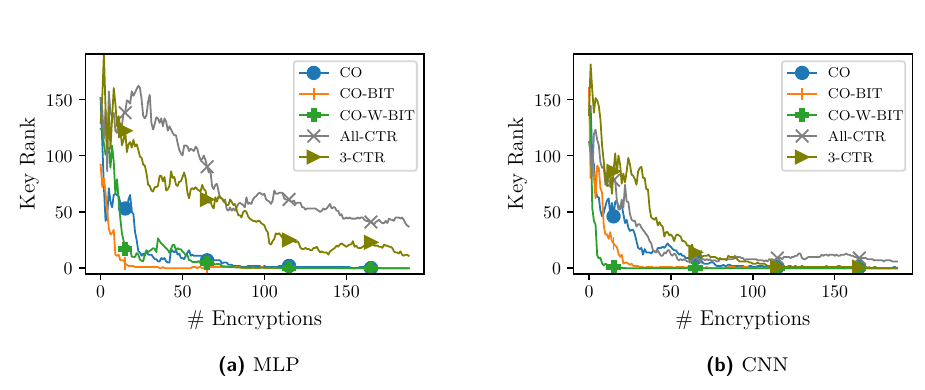
Figure 7: Attack results for the first round